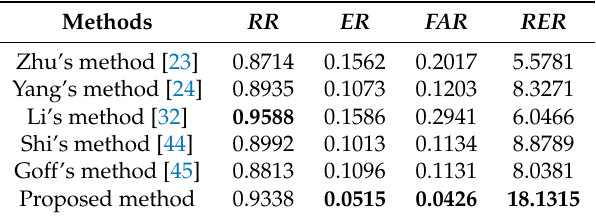
Table 4. Statistical results of different cloud detection